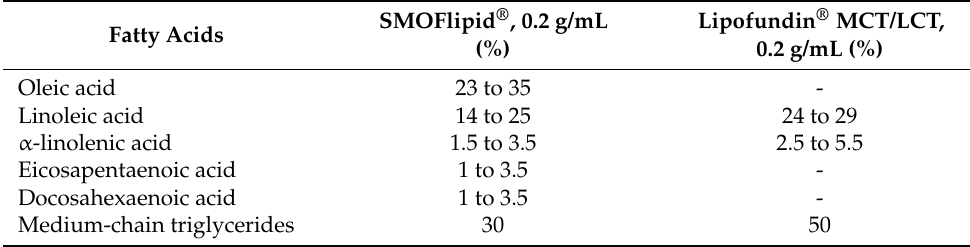
Table 1. Composition of main fatty acids in Smoflipid ® and Lipofundin ® MCT/LCT. SMOFlipid ® , 0.2 g/mL Lipofundin ® MCT/LCT, Fatty Acids (%) 0.2 g/mL (%) Oleic acid 23 to 35 - Linoleic acid 14 to 25 24 to 29 α -linolenic acid 1.5 to 3.5 2.5 to 5.5 Eicosapentaenoic acid 1 to 3.5 - Docosahexaenoic acid 1 to 3.5 - Medium-chain triglycerides 30